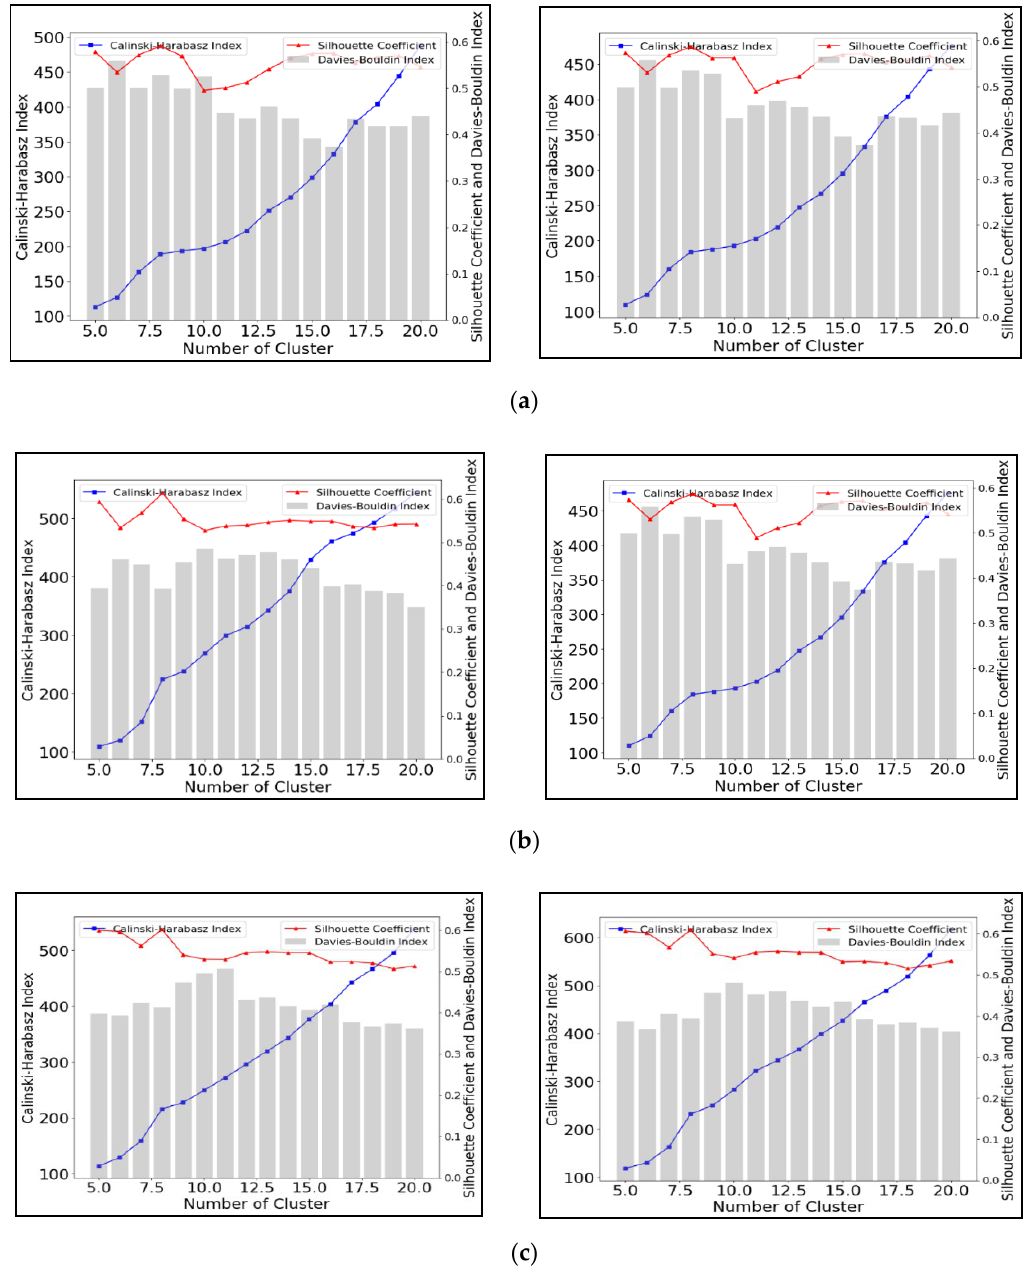
Figure 6. Performance evaluation for Agglomerative Clustering with different cluster numbers under synthetic rainfall scenarios including ( a ) 3-h (left 2-year and right 5-year), ( b ) 12-h (left 2-year and right 5-year), and ( c ) 48-h duration (left 2-year and right 5-year).